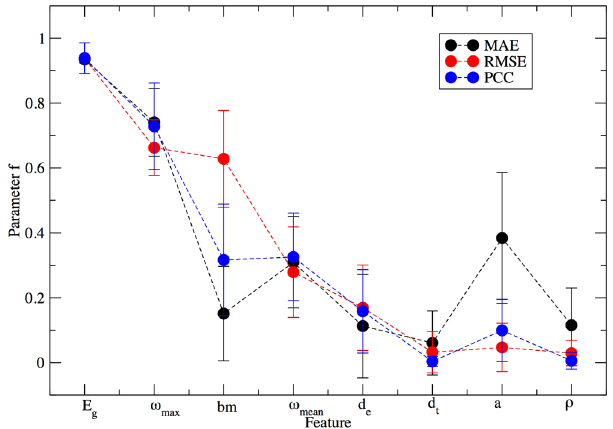
Figure 1. The frequency with which each of the eight features appears on the Pareto frontier (parameter f). Error bars are from eight parallel Eureqa